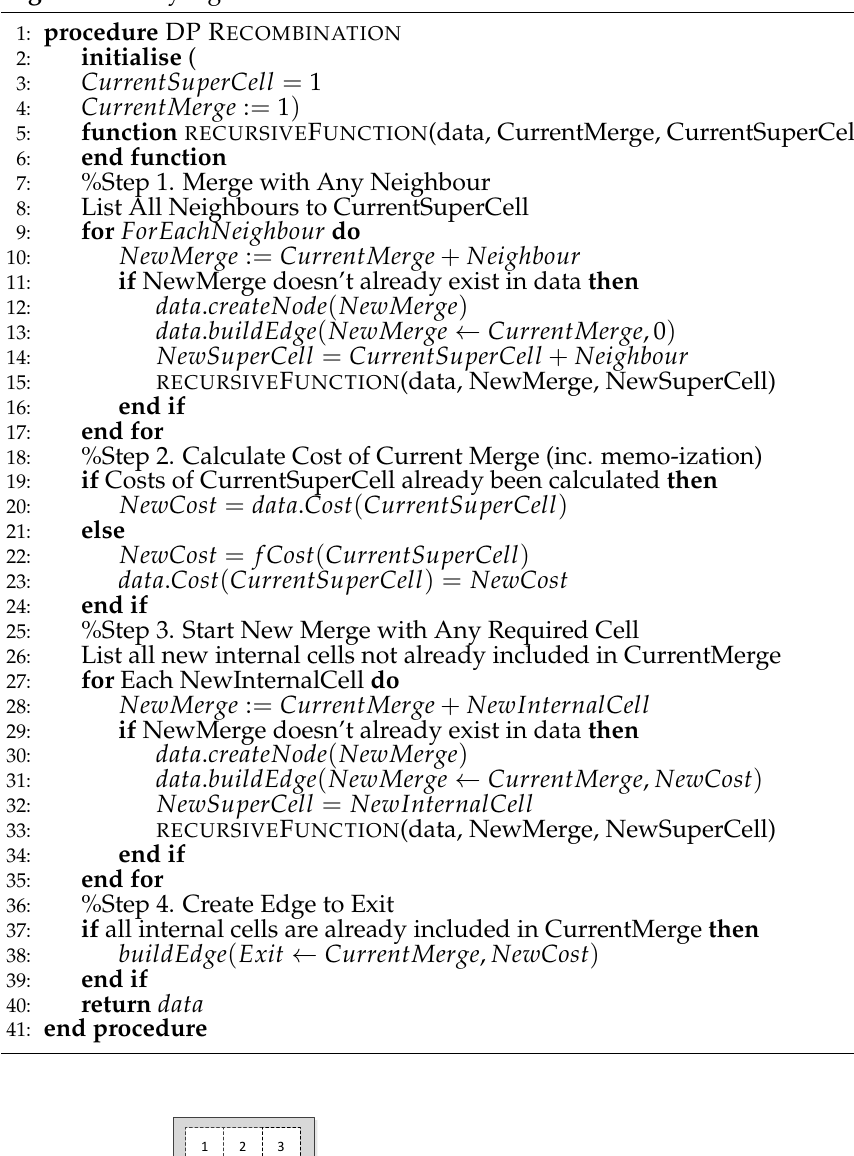
Algorithm 1 My algorithm